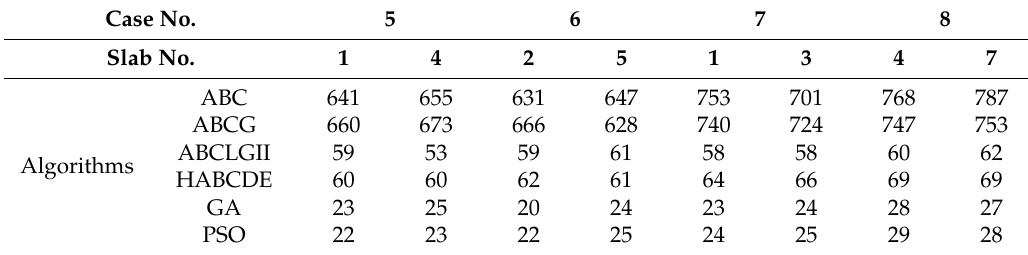
Table 10. Time cost for case 5 to case 8 (unit: